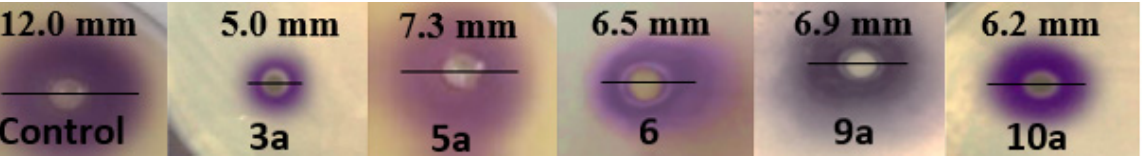
Figure 5. Anti-QS activity via signal inhibition in S. aureus . Control well, QS signals produced exogenously and diffused through S. aureus ; these molecules were traced with purple pigmentation, produced by CV026 in Soft Top agar. In the presence of the sub-MICs of the compounds 3a , 5a , 6 , 9a , and 10a , bacterial culture (10 6 CFU/mL) was used, and the QS signal diffusion zone was decreased compared with the control well (mean ± SD, p < 0.05).